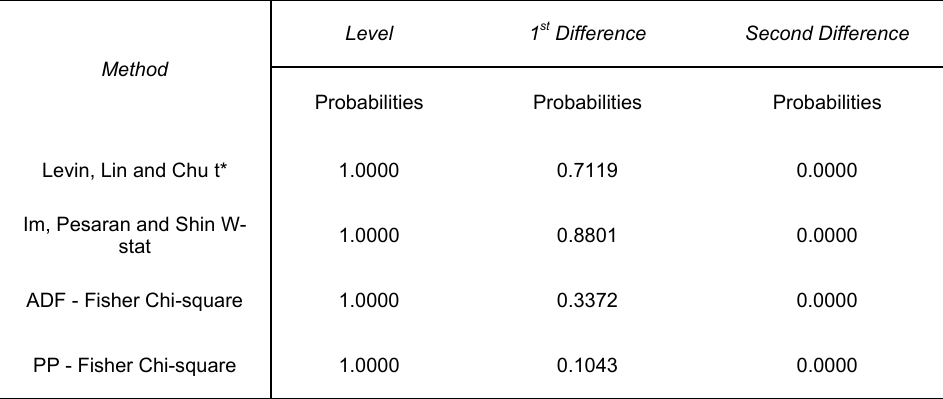
Table 3: Unit Root Test (GDP)